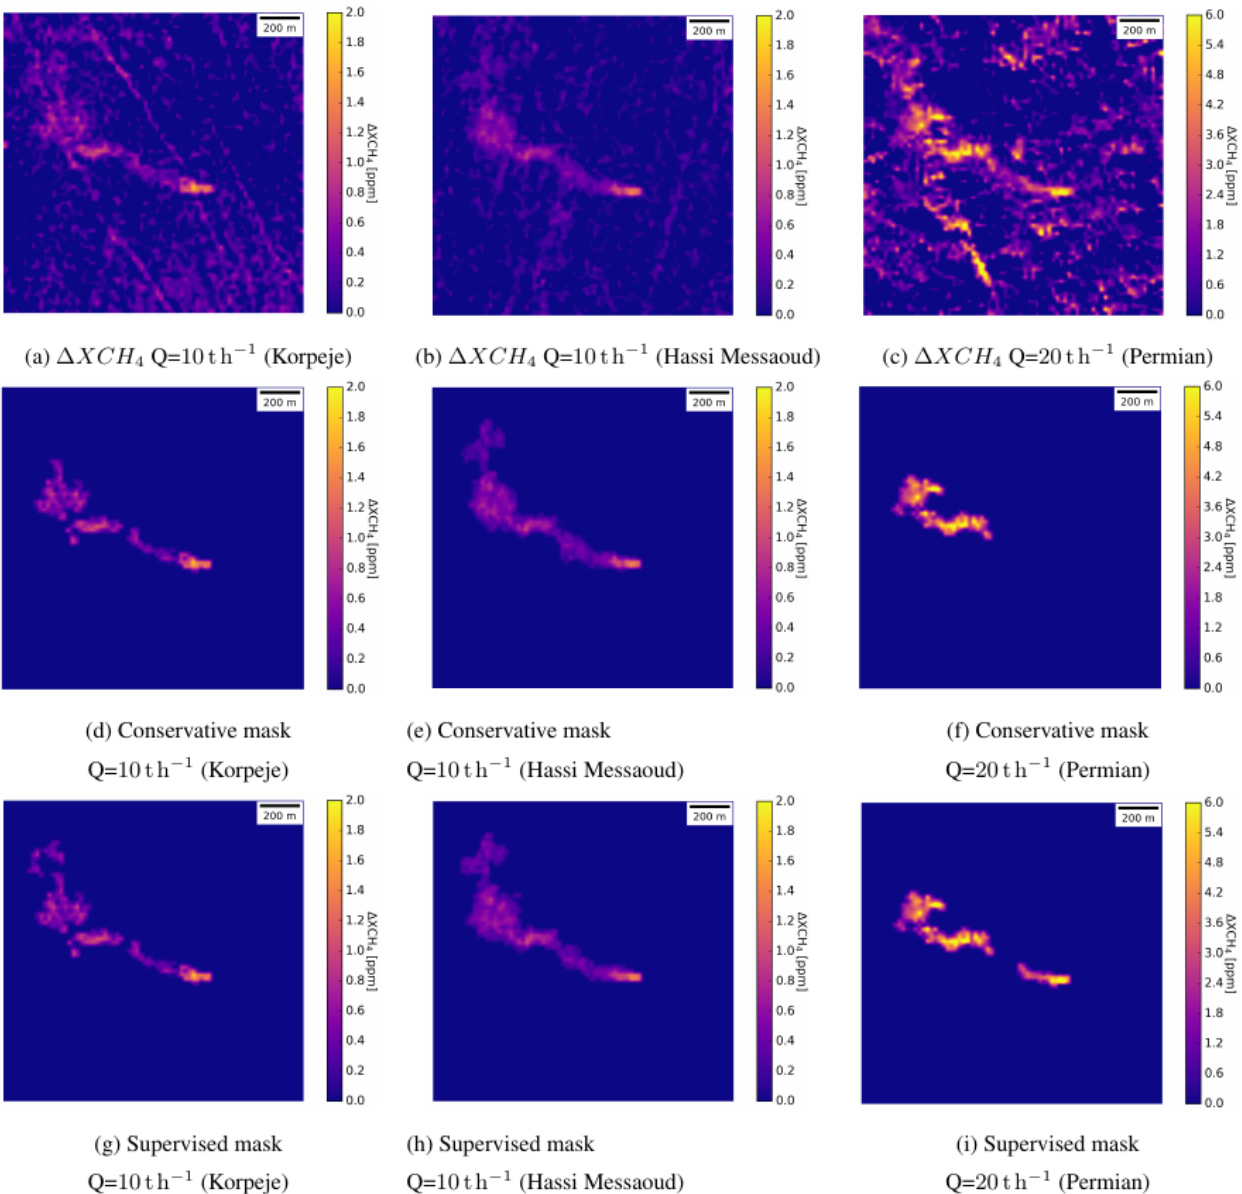
Figure 7. Results of the retrieval for the simulated datasets that include the map of (cid:49)X CH under a conservative masking criteria (d, e, f) and a supervised masking criteria (g, h, i) . The selected simulations include the methane plume 2 (see Fig. 3b) with a flux rate Q = 5000kgh − 1 for Korpeje and Hassi Messaoud and Q = 20000kgh − 1 for the Permian Basin. Note the different color bar bounds for the Permian scene than for the Korpeje and Hassi Messaoud